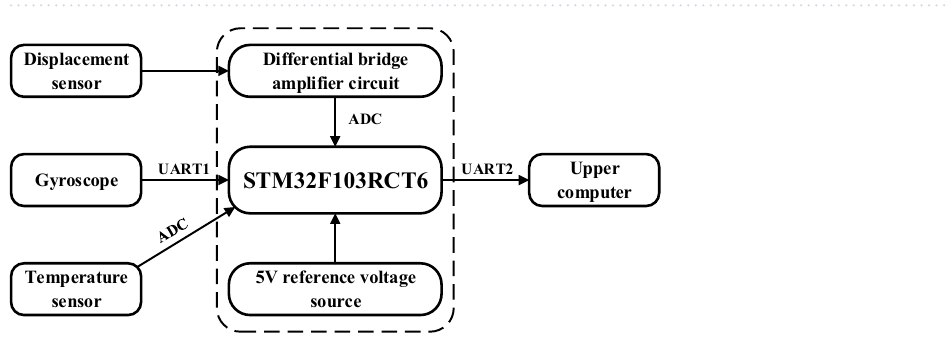
Figure 8. Influence of parameters of the cross beam on the surface strain of the cantilever beam (( a , b ) were generated by Origin 2016 × 64 (https:// www. origi nlab. com/ 2016)).